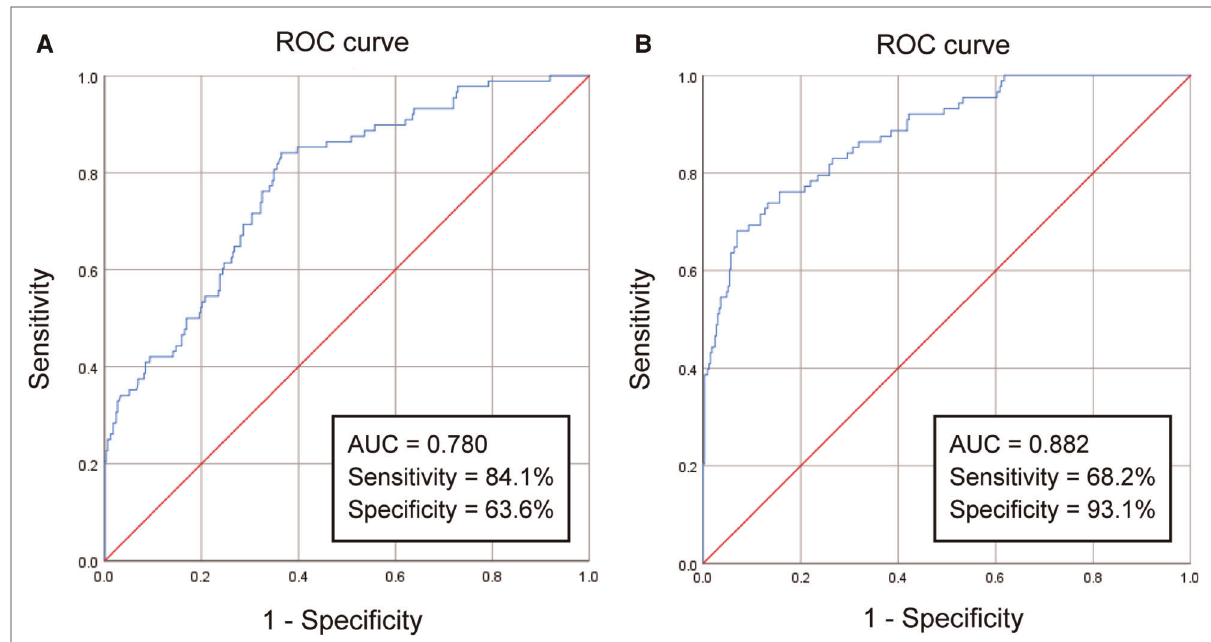
FIGURE 2 The results of ROC-curve analysis: ( A ) the ROC curve of the NLR for predicting off-pump CABG-associated AKI. ( B ) The ROC curve of the predictive model.